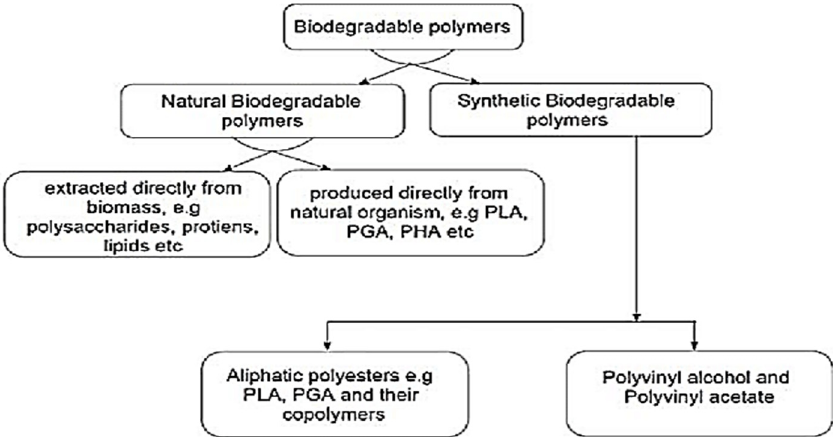
Figure 2. The biodegradable classification of polymers constituents in green composites. (Reproduced with a copyright permission from Karande et al. [24]).